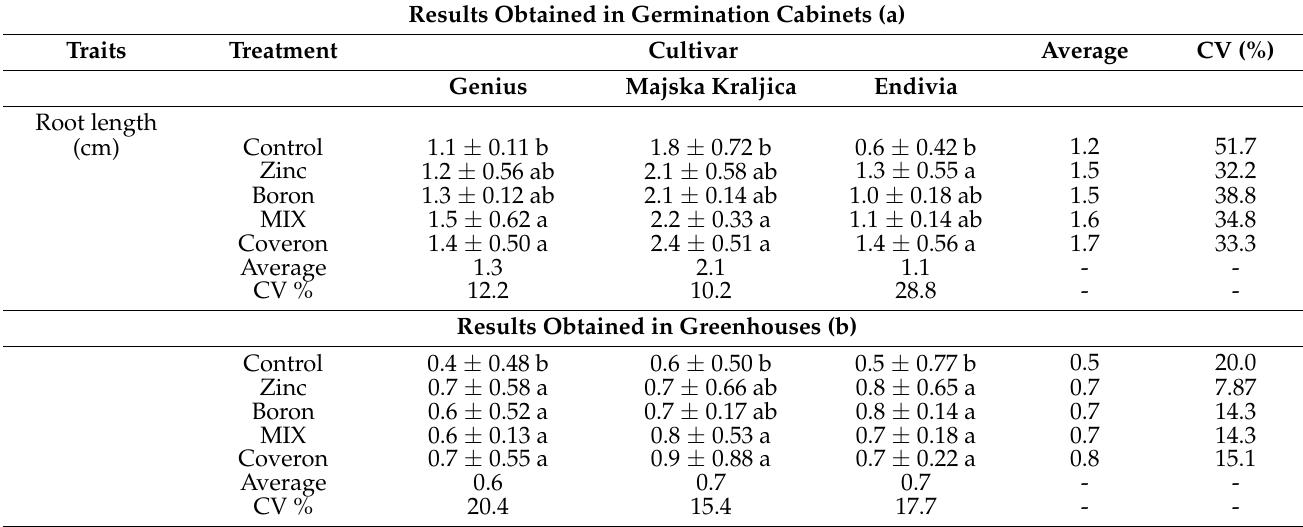
Table 3. Growth of root length after treatments applied to lettuce cultivars. Results Obtained in Germination Cabinets